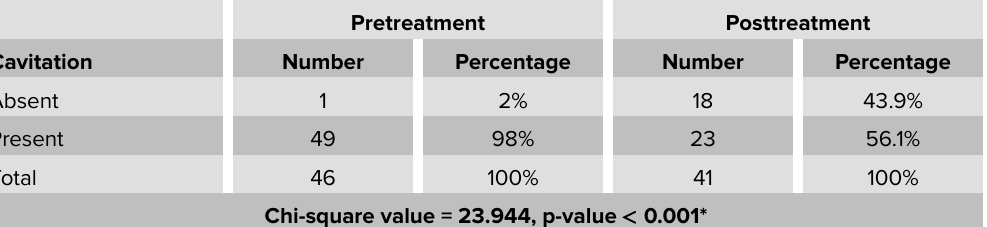
TABLE 4: Frequency distribution of cavitation in pre- and posttreatment cases.